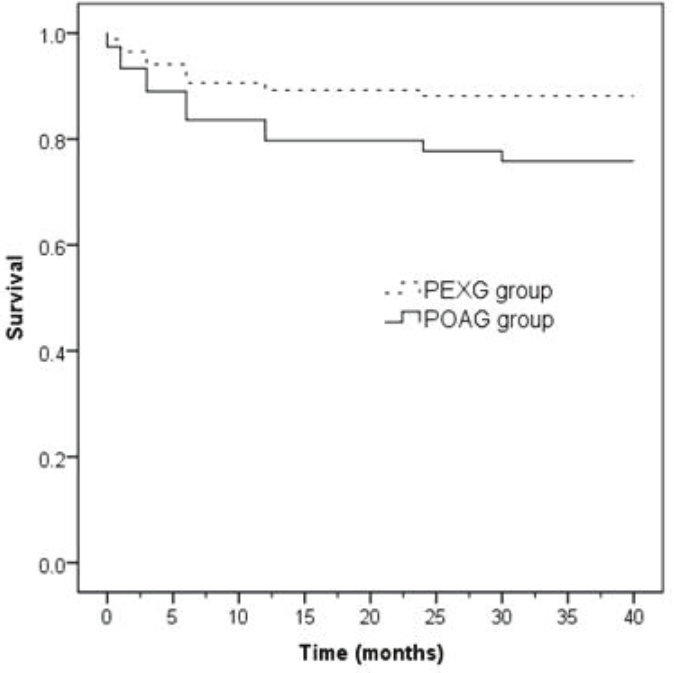
Figure 2. Kaplan–Meier survival curve of complete success (IOP < 21 mmHg without medication) in pseudoexfoliation glaucoma (PEXG) and primary open-angle glaucoma